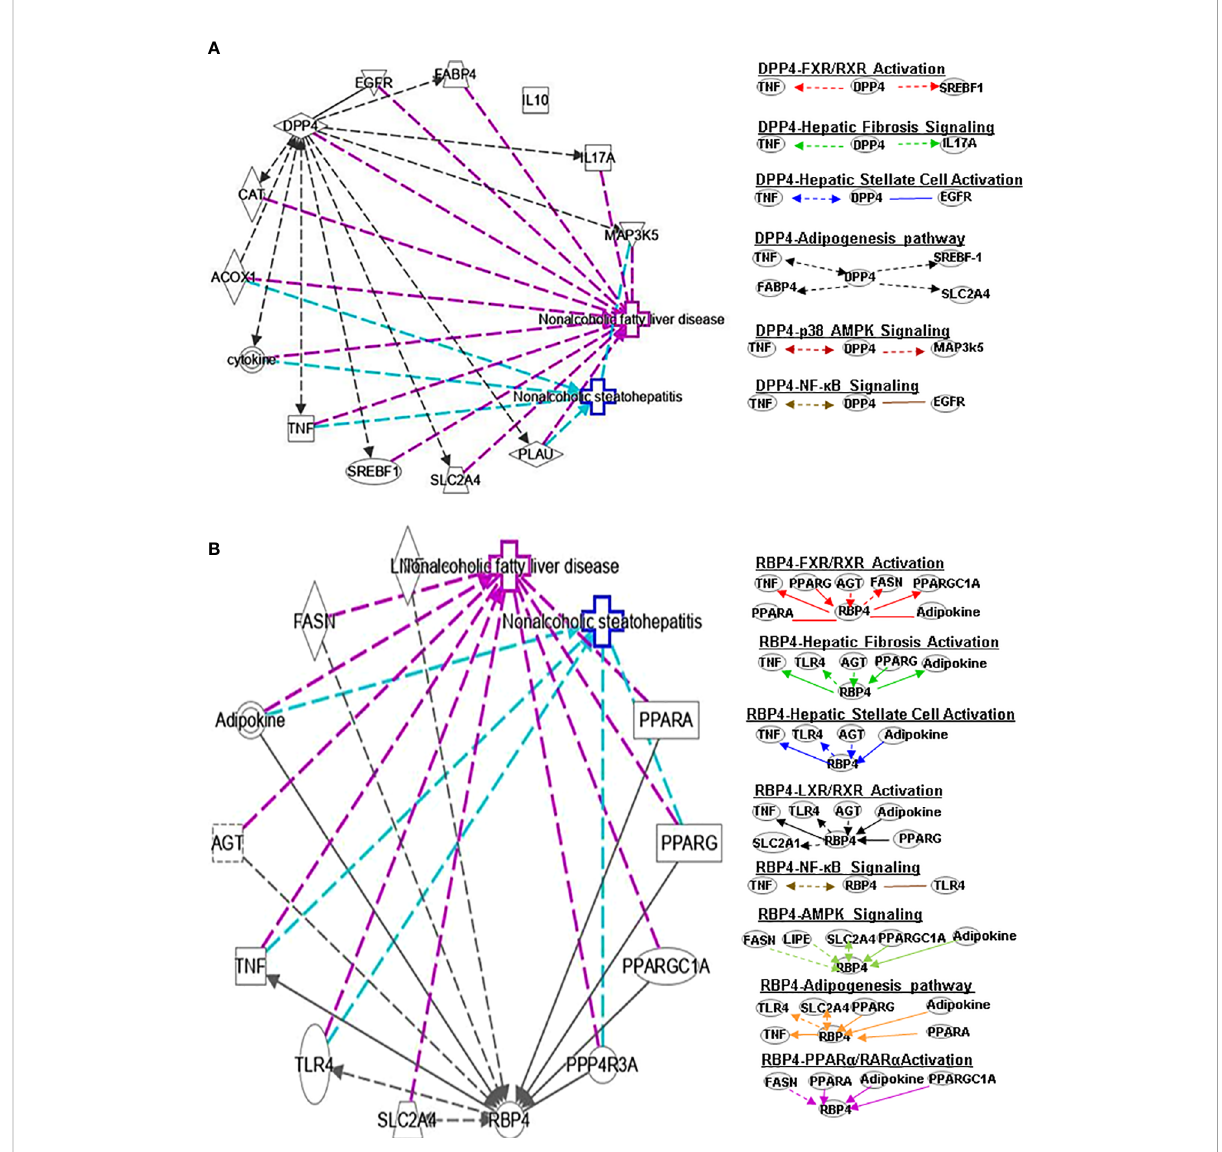
FIGURE 2 Ingenuity pathway analysis (IPA) of DPP4 and RBP4. (A) IPA investigated the molecular pathways of DPP4 involved in NAFLD and NASH. All identi fi ed pathways of RBP4 were screened individually. Representative canonical pathways of RBP4 are associated with other related genes and molecules of NAFLD and NASH. Functional relationships of these genes, molecules and DPP4 are depicted using straight lines with arrows. DPP4 is functionally related to 1. FXR/RXR signaling; 2. Hepatic fi brosis signaling; 3. Hepatic stellate cell activation; 4. Adipogenesis pathway; 5. p38-AMPK signaling and 6. NF- k B signaling (Right). (B) IPA investigated the molecular pathways of RBP4 involved in NAFLD and NASH. All identi fi ed pathways of RBP4 were screened individually (left). Representative canonical pathways of RBP4 are associated with other related genes and molecules of NAFLD and NASH. Functional relationships of these genes and RBP4 are depicted using straight lines with arrows. RBP4 is functionally related to 1. FXR/RXR signaling; 2. Hepatic fi brosis signaling; 3. Hepatic stellate cell activation; 4. LXR/RXR pathway and 5. NF- k B signaling (Right). Solid lines show direct regulation while dotted lines depict indirect interactions. SLC2A4, Solute carrier family 2 member 4; MAP3k5, Mitogen-activated protein kinase kinase kinase 5; AGT,